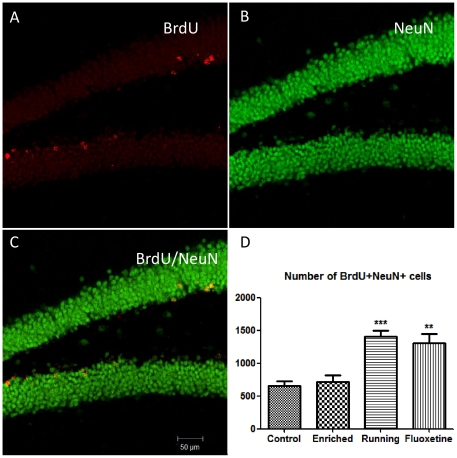
Cell survival and neurogenesis in the four different groups.BrdU (200 mg/kg) was injected into all mice before dividing them into different groups. After 28 days, brain tissues (hippocampus) were stained for BrdU and NeuN (A–C). The exercise and fluoxetine groups, but not the enriched environment group, showed higher number of BrdU and NeuN positive cells in the dentate gyrus (D) compared to the control group. Values are means ± SEM. **P<0.01, ***P<0.001.